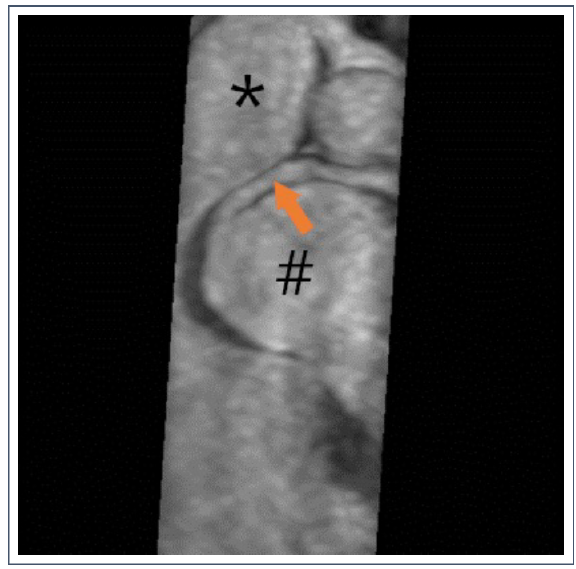
Figure 11. 36-year-old pentathlete with anomalous right coronary artery (RCA). Dominant RCA (orange arrow) originates from the left sinus Valsalva and runs between the aorta (#) and the truncus pulmonalis (*).